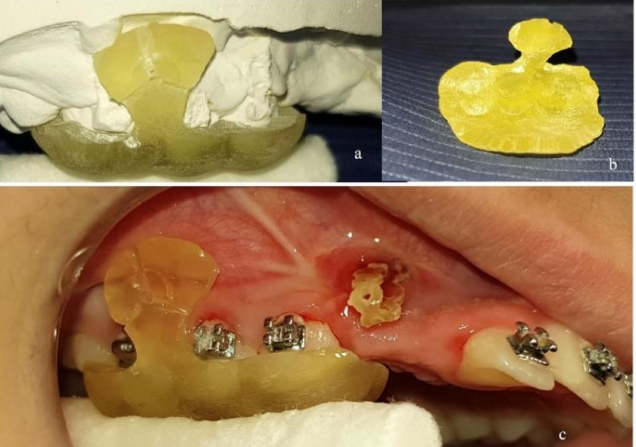
Figure 2. ( a ) Surgical guide 3D-printed in biocompatible resin and tested for proper fitting on plaster model. ( b ) Inner side of the surgical guide. ( c ) Surgical guide tested for proper fitting in patient’s